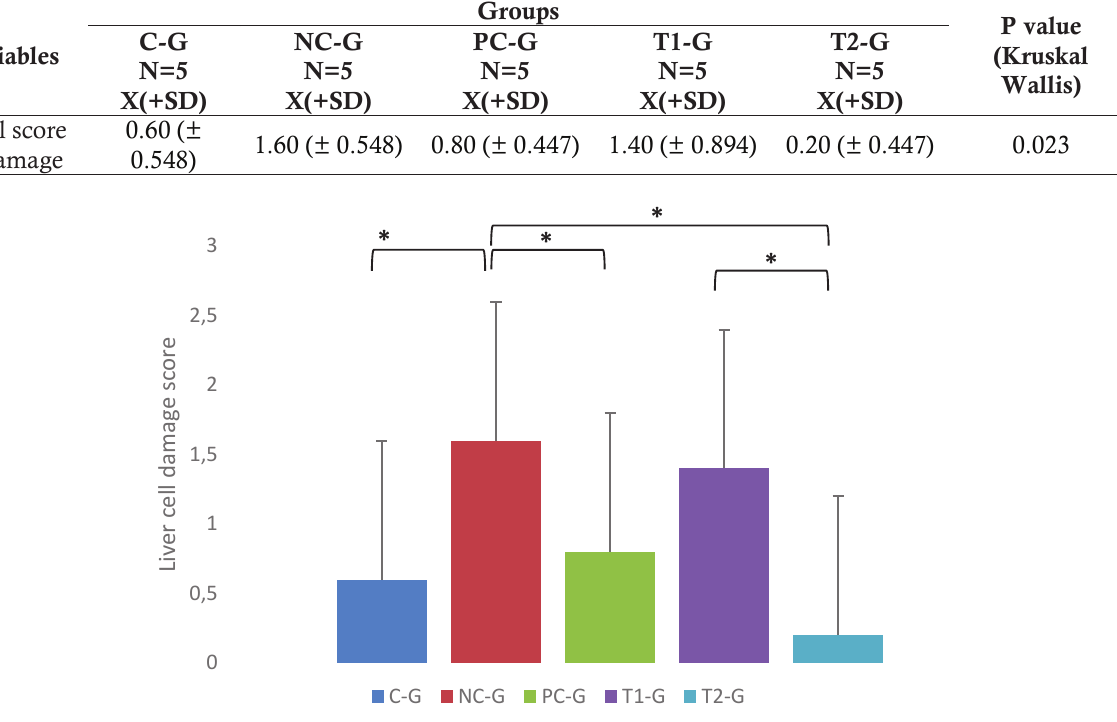
Figure 1. The histogram of differences between groups.